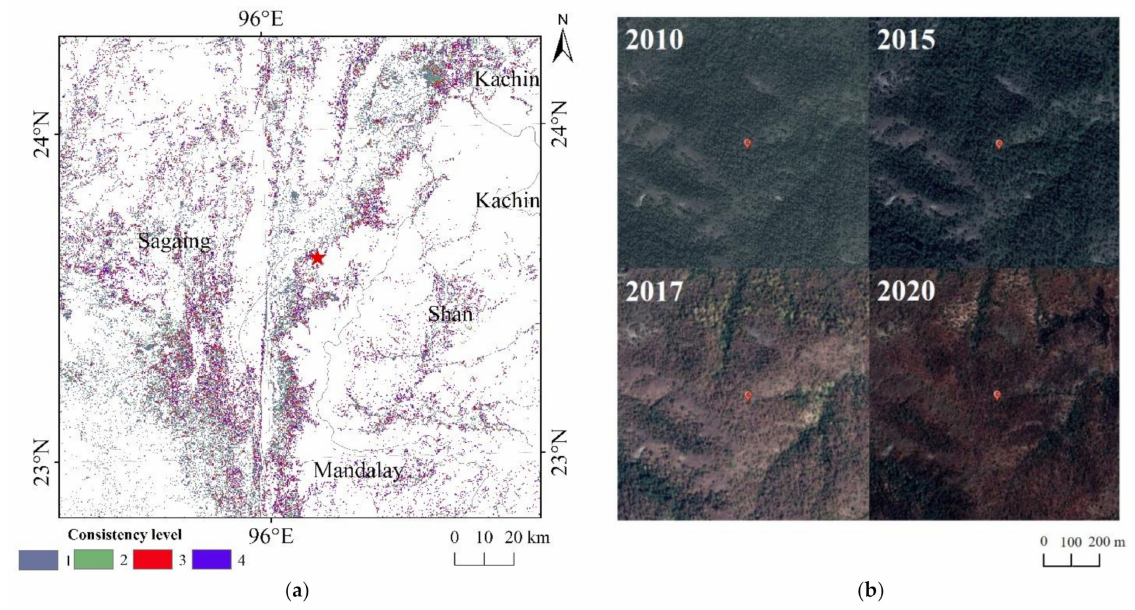
Figure 13. Examples of actual forest change in Myanmar, 2010–2020. ( a ) Differences between datasets; ( b ) Actual forest change during 4